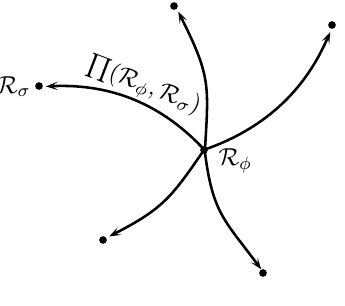
Figure 2. Outgoing flow of Figure 2: Outgoing flow of